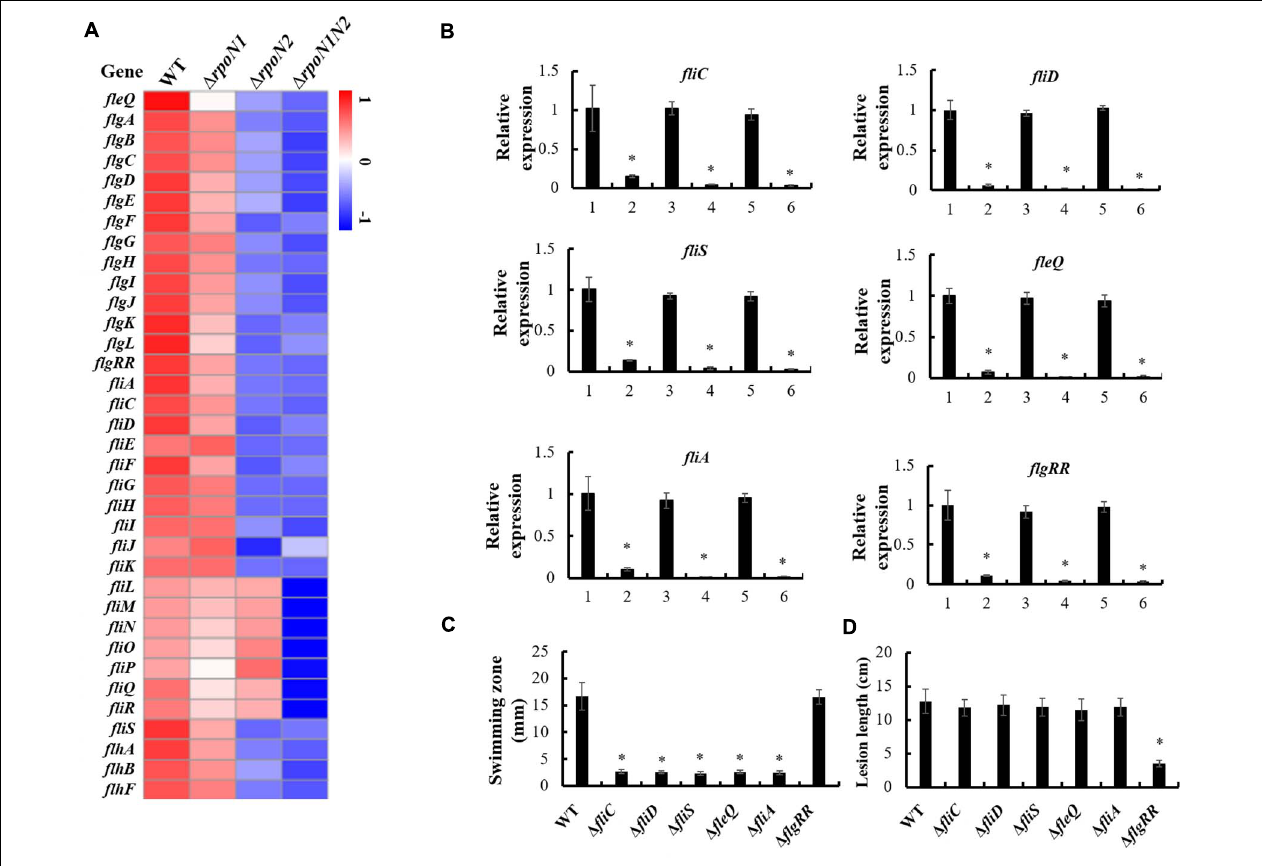
FIGURE 6 | RpoN1 and RpoN2 regulated flagellar assembly. (A) Heat map of flagellar assembly associated genes expression. (B) The expression patterns of fliC , fliD , fliS , fleQ , fliA, and flgRR in (cid:49) rpoN1 , (cid:49) rpoN2, and (cid:49) rpoN1N2 were validated using qRT-PCR. 1, WT; 2, (cid:49) rpoN1 ; 3, (cid:49) rpoN1 -C; 4, (cid:49) rpoN2 ; 5, (cid:49) rpoN2 -C; 6, (cid:49) rpoN1N2 . (C) Swimming motility was tested in (cid:49) fliC , (cid:49) fliD , (cid:49) fliS , (cid:49) fleQ , (cid:49) fliA , and (cid:49) flgRR . (D) Virulence was detected in (cid:49) fliC , (cid:49) fliD , (cid:49) fliS , (cid:49) fleQ , (cid:49) fliA , and (cid:49) flgRR . Asterisks indicate significant differences between WT and mutants ( P -value < 0.05) (Student’s t